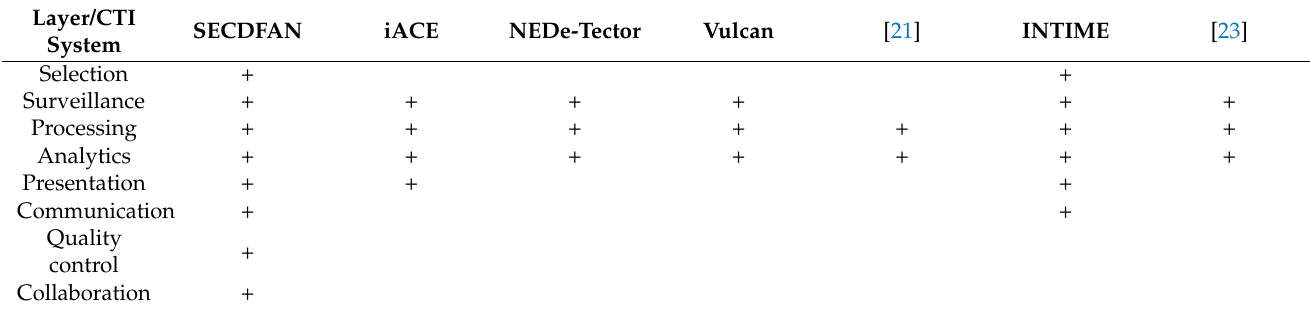
Table 11. Comparison of Architectures of CTI